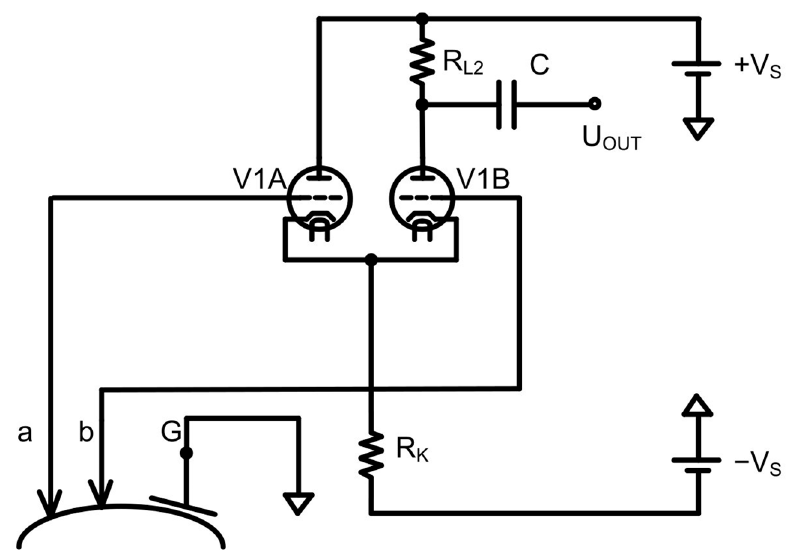
Figure 4. The first vacuum tube differential bioamplifier cascade under US patent no. 2,147,940 [10].